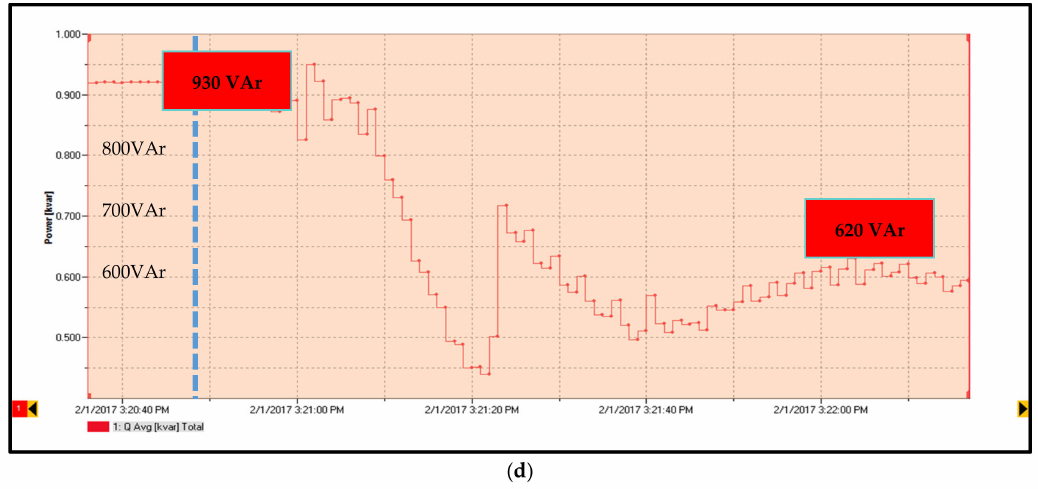
Figure 17. Grid side experimental waveforms for no load test (3): ( a ) speed (V), ( b ) phase A grid voltage and current, ( c ) grid active power (W) [ Y-axis: 25W / div, X-axis: 30s / div ], and ( d ) grid reactive power (VAr) [ Y-axis: 50VAr / div, X-axis: 10s / div ].